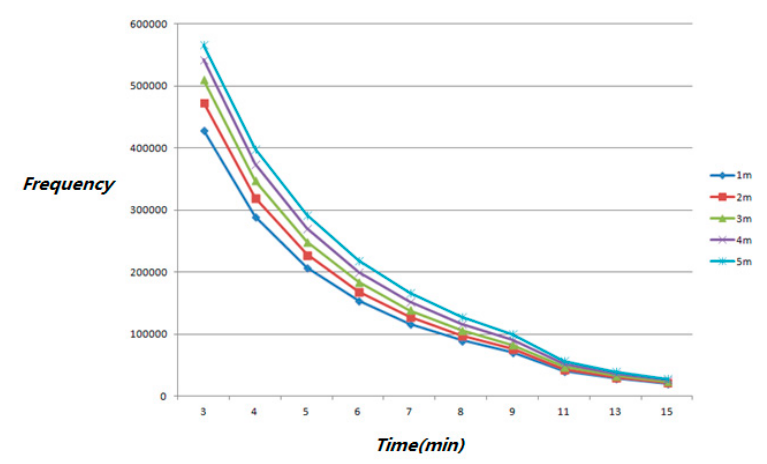
Figure 7. Time threshold determination.